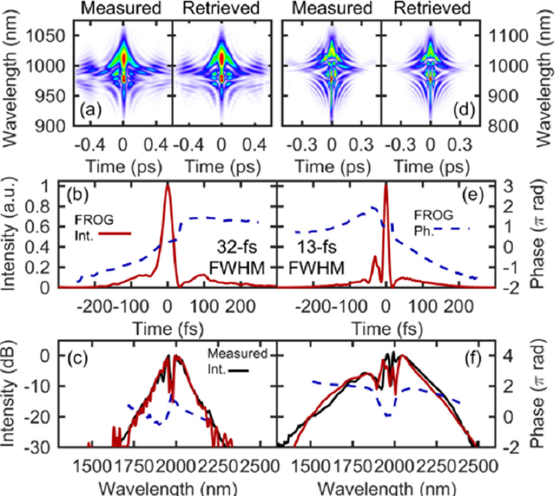
Figure 26. ( a ) Measured (left)and retrieved (right) FROG spectrograms of the longer pulse PCF compression channel. ( b ) Retrieved FROG temporal intensity and phase. ( c ) Retrieved FROG spectral intensity and phase compared to independently measured spectrum obtained using a NIR grating spectrometer. ( d – f ) shows the same information as ( a – c ), this time measured for the shorter pulse PCF channel. Reprinted with permission from